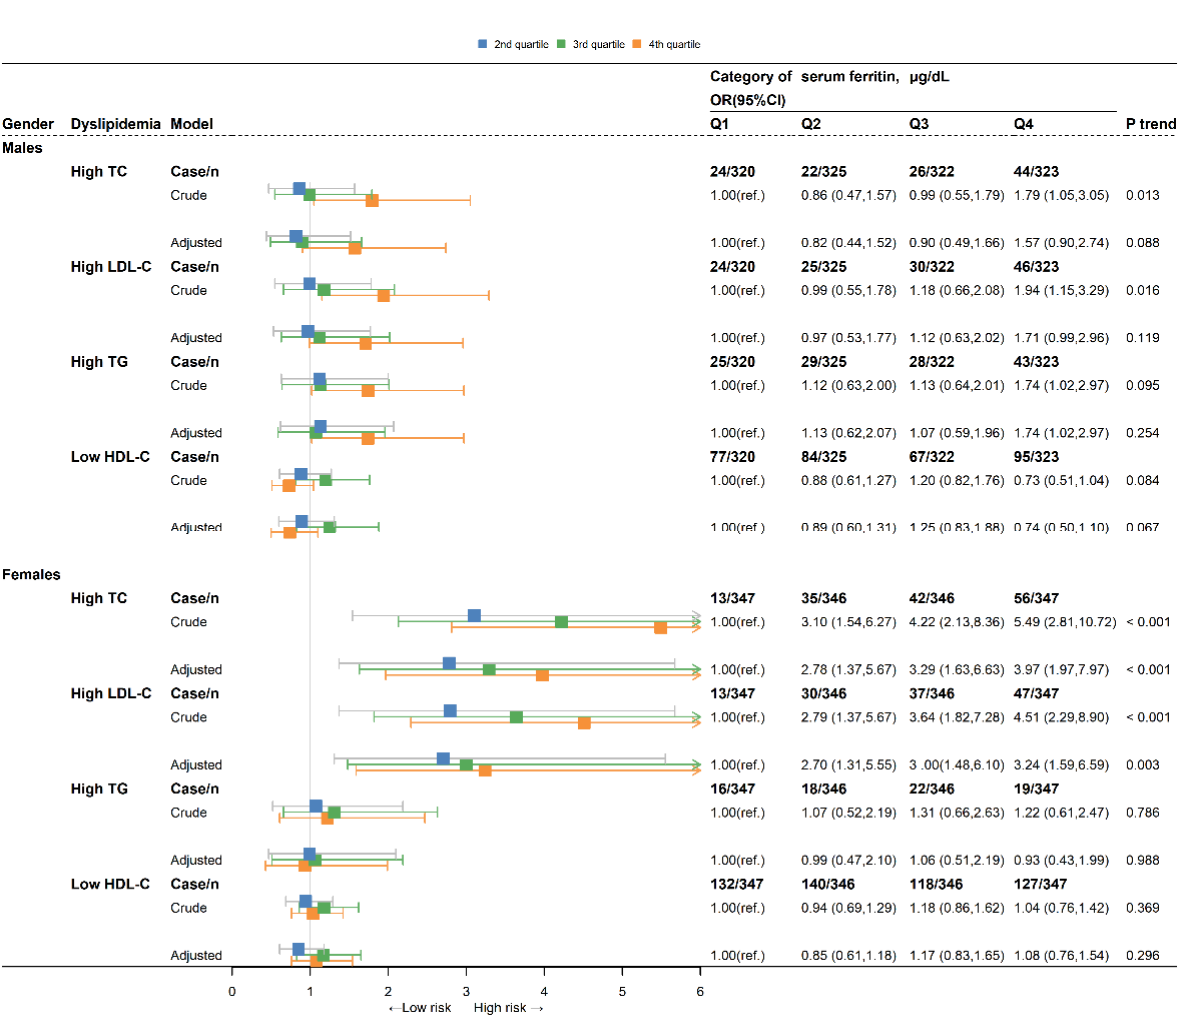
5 of 13 Figure 2. ORs (95% CIs) for dyslipidemia according to serum ferritin in males and females. OR, odds